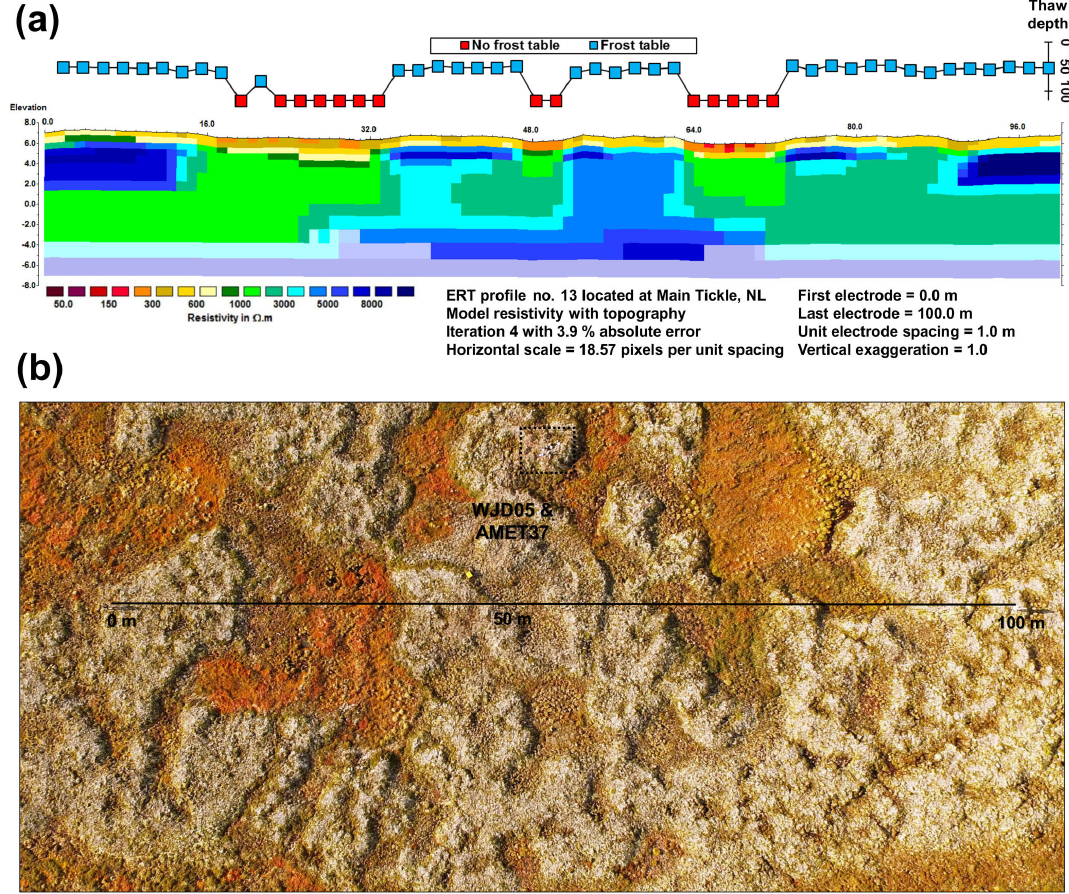
Figure 9. Peatland permafrost at Main Tickle. (a) Frost tables and modelled resistivities on ERT profile 13. Note that the colour scale differs from that in Figs. 3–7 to differentiate among zones of high resistivity. Consequently, some green zones on this modified scale are inferred to be frozen. (b) UAV vertical image of the site. Black line delimits the approximate location of the ERT survey line and text shows the start and end